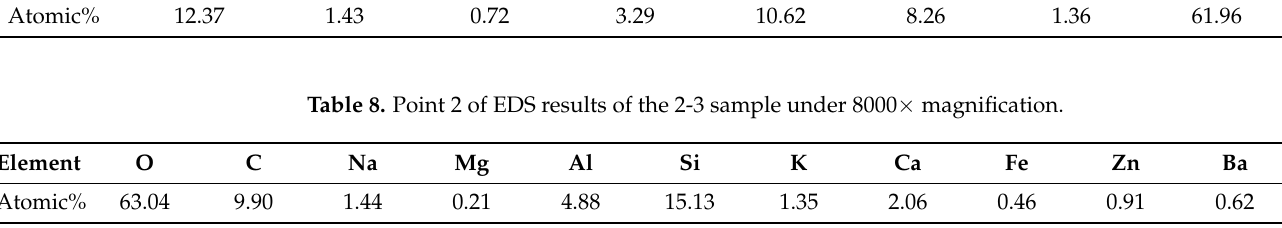
Table 7. Point 1 of EDS results of the 2-3 sample under 8000 × magnification. Element